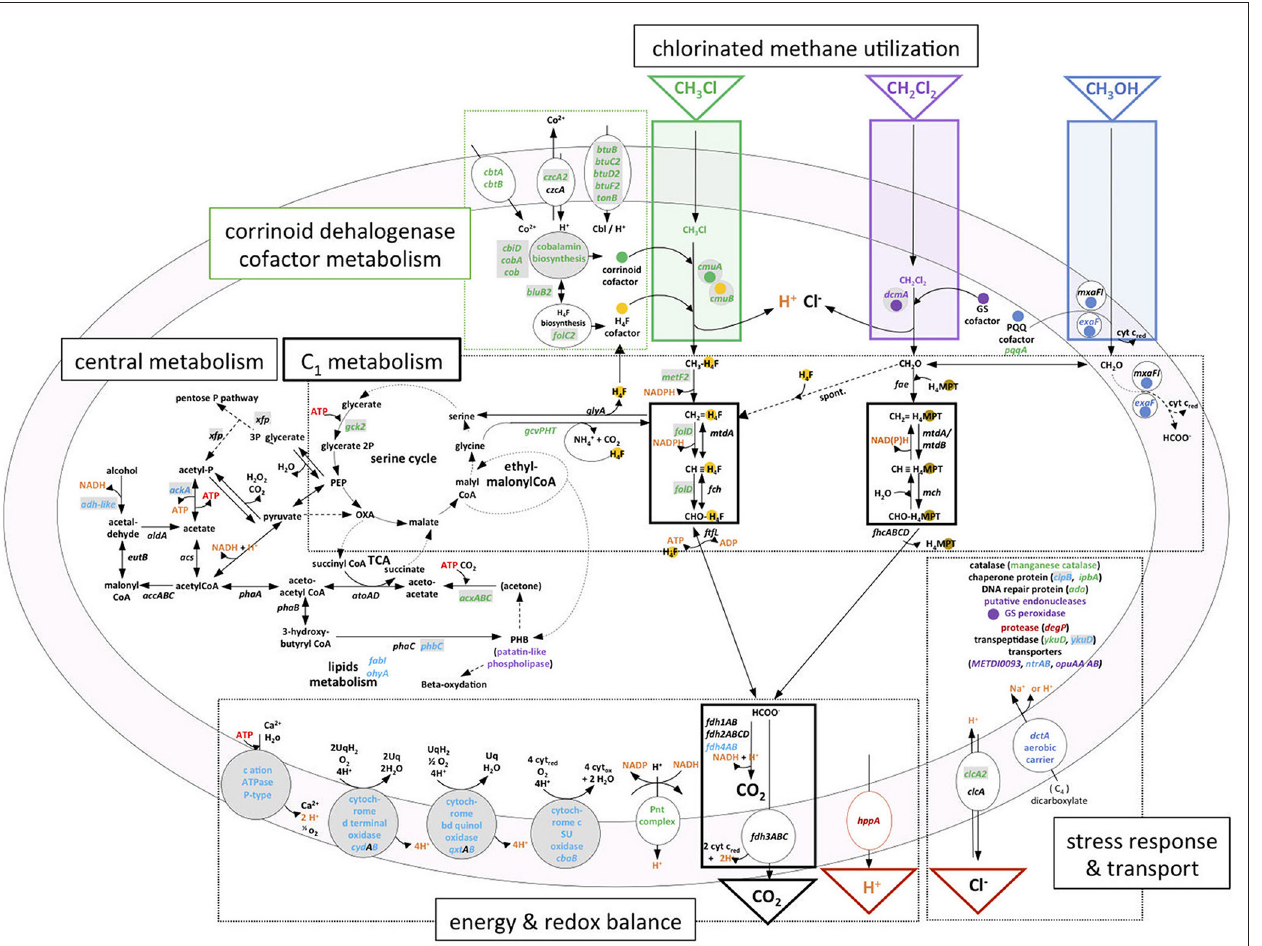
FIGURE 6 | Transcriptional response and metabolism of chlorinated C 1 compounds chloromethane and dichloromethane in M. extorquens . Chloromethane dehalogenation and methyl transfer to tetrahydrofolate (H 4 F) reactions are boxed in green; dichloromethane dehalogenation to formaldehyde in purple; methanol oxidation to formaldehyde in blue. Within C 1 metabolism, black boxes delimit common methylotrophic modules (Chistoserdova et al., 2009): H 4 F and tetrahydromethanopterin (H 4 MPT)-dependent C 1 transfer reactions, and formate oxidation for C 1 dissimilation with C0 2 production. Serine and ethylmalonyl-CoA cycles for C 1 assimilation ( Ochsner et al., 2015) are schematized with two connected circles. Reactions related to essential co-factors for chlorinated methane utilization are highlighted with colored spots; H 4 F (yellow), corrinoid cofactor (green), glutathione (purple), and pyrroquinoline quinone (blue). GEI-located genes in M. extorquens DM4 or in M. extorquens CM4 (plasmid pCMU01) are shown in gray-shaded boxes. RNA-Seq data are summarized using gene color-coding for more abundant transcripts on CM (green), DCM (purple), both CM and DCM (dark red), methanol [both M. extorquens CM4 and DM4 (dark blue), DM4 only (light blue)]. Compounds associated with energy-dependent transformations are highlighted in orange. Cbi, cobinamide; Cbl, cobalamin; CoA, coenzyme A; PEP, phosphoenolpyruvate; OXA, oxaloacetate; TCA, tricarboxylic acid